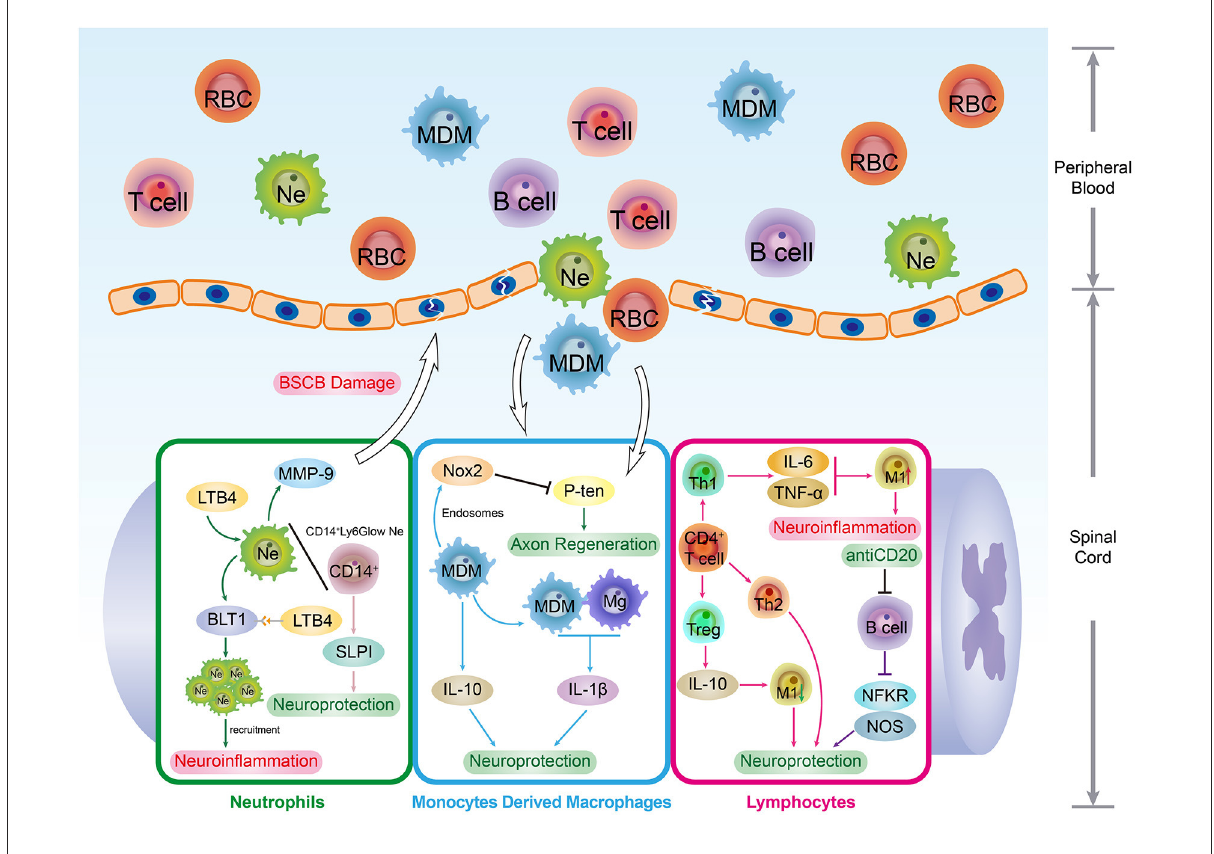
FIGURE2 The immune roles of peripheral immune cells. The SCI events not only interrupt the BSCB integrity but break the intraspinal immune homeostasis. With the permeability elevation, peripheral immune cells such as neutrophils (Ne), monocytes derived macrophages (MDM) and lymphocytes are infiltrated in spinal cord lesions. In spinal cord lesions, these peripheral phagocytes. As the typical peripheral phagocytes, Ne and MDM cells also work as immune regulators in CNS. By interacting with immune factors in the spinal cord microenvironment, Ne and MDM played both positive and negative roles in regulating SCI recovery. In addition, the infiltration of lymphocytes enables the adaptive immune response to occur in the spinal cord, which provides significant immunomodulation for SCI pathological repair process. Interestingly, lymphocytes are competent in regulating the phenotype transformation of macrophages. To illustrate, the Th1 cells expressed cytokines such as TNF- α and IL-6 induce the transformation and activation of M1-type macrophages which results in extensive demyelination and neural tissue